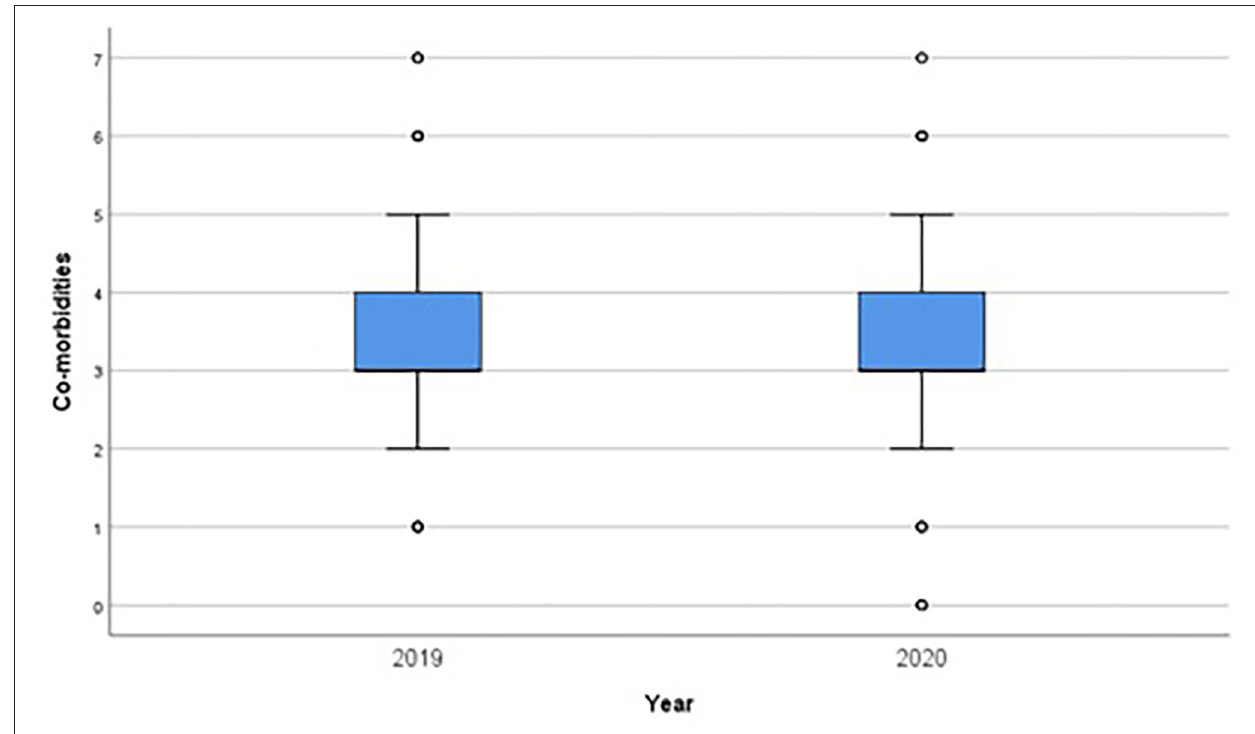
FIGURE 3 | Number of comorbidities in 2019 and